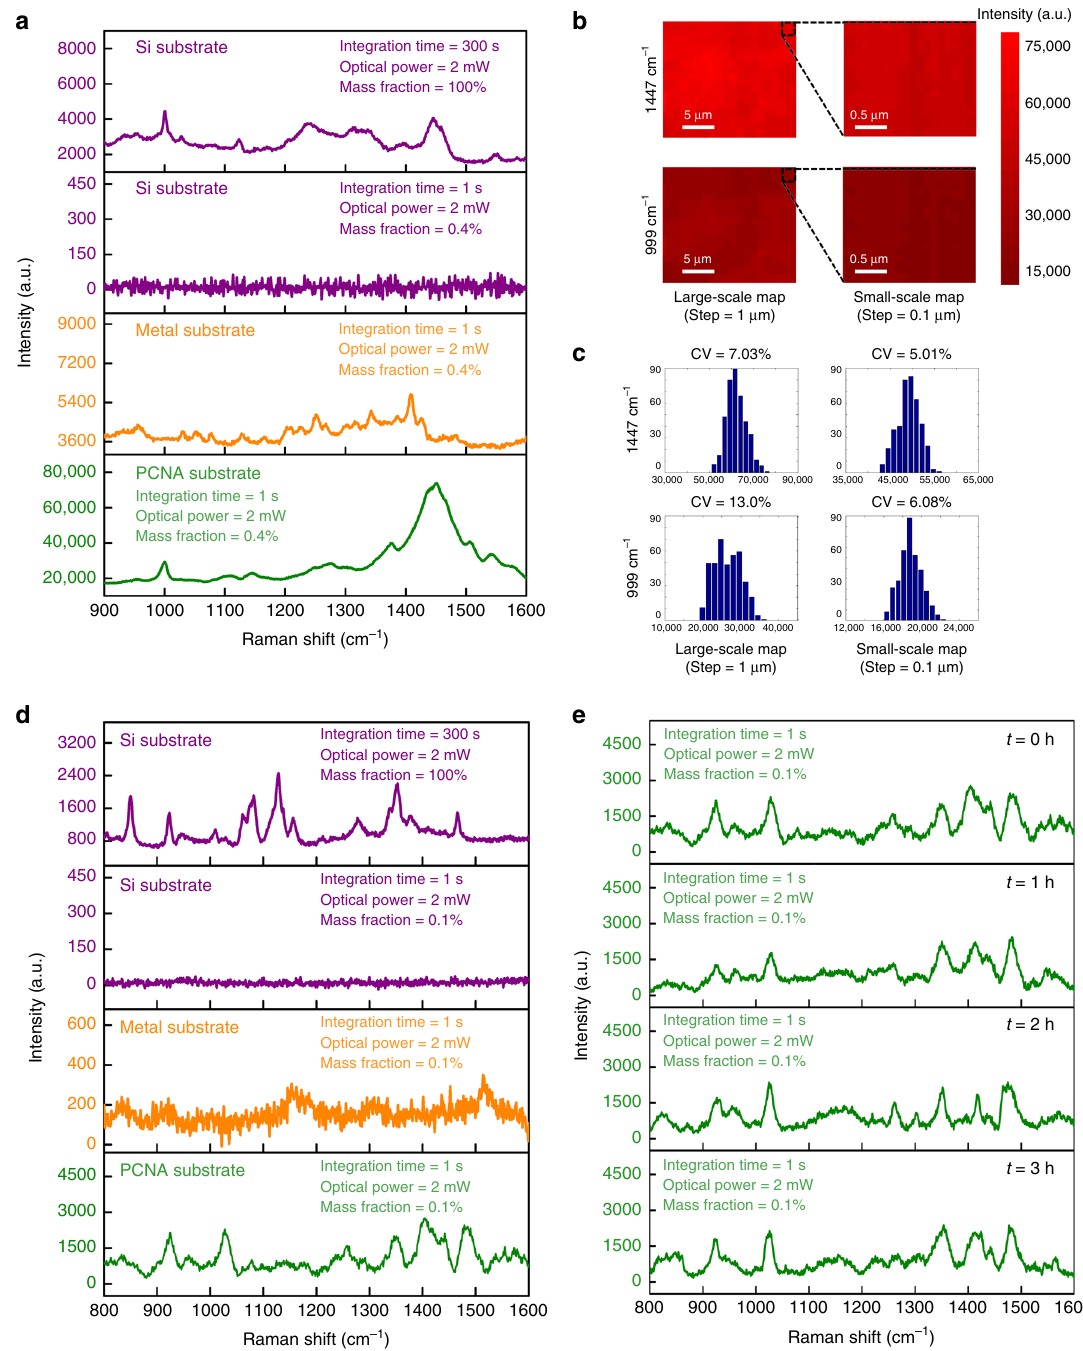
Fig. 3 SERS of biomolecules ( β -lactoglobulin and glucose) on the PCNA substrate. a Measured Raman spectra of β -lactoglobulin molecules on the silicon, PCNA, and commercial metal substrates. The Raman signal intensity of β -lactoglobulin molecules on the PCNA substrate is 10 times higher than that on the metal substrate. b SERS maps of β -lactoglobulin on the PCNA substrate, showing high surface homogeneity in enhancement factor at two characteristic Raman shifts of the molecule on both large and small scales with a step size of 1 and 0.1 µ m, respectively. c Histograms of the enhancement factors on the large and small scales. d Measured Raman spectra of glucose molecules on the silicon and PCNA substrates. e Time-to-time consistency of the PCNA substrate in the Raman spectrum of glucose. Small hour-to-hour fl uctuations in the Raman spectrum indicate high reproducibility and